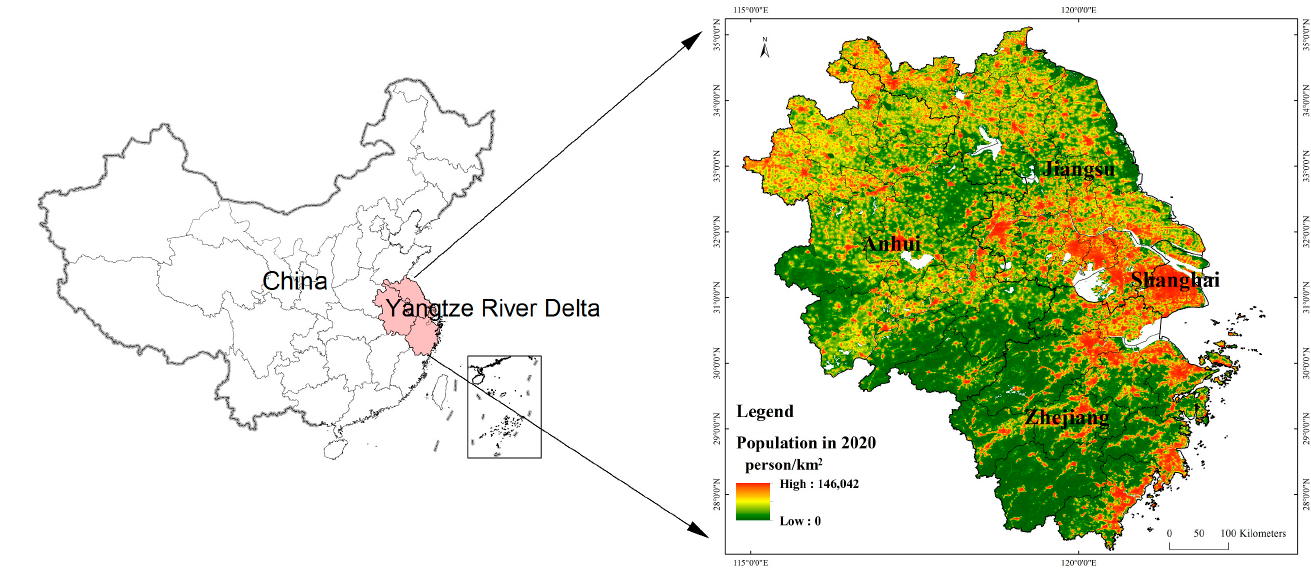
Figure 1. Geographic location and population distribution of the Yang tz e River Delta.